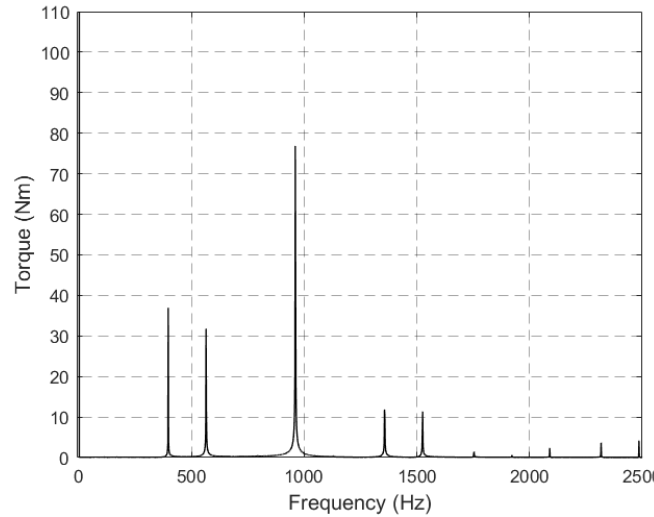
Figure 14. Torque amplitude frequency spectrum, f ∈ (0, 2.5 kHz).